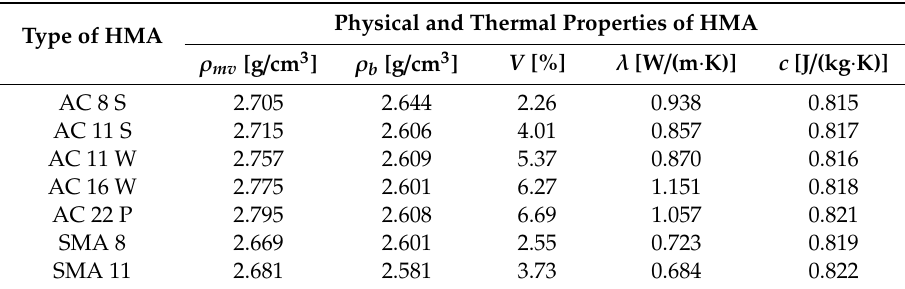
Table 2. Thermophysical parameters of the HMA samples. Type of